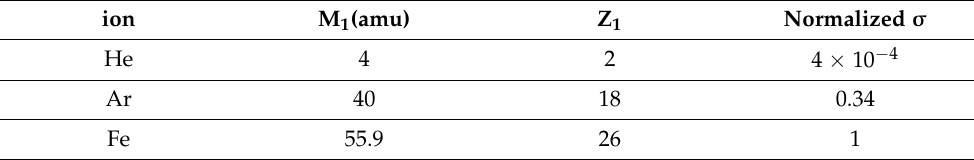
Table 2. Normalized ion cross